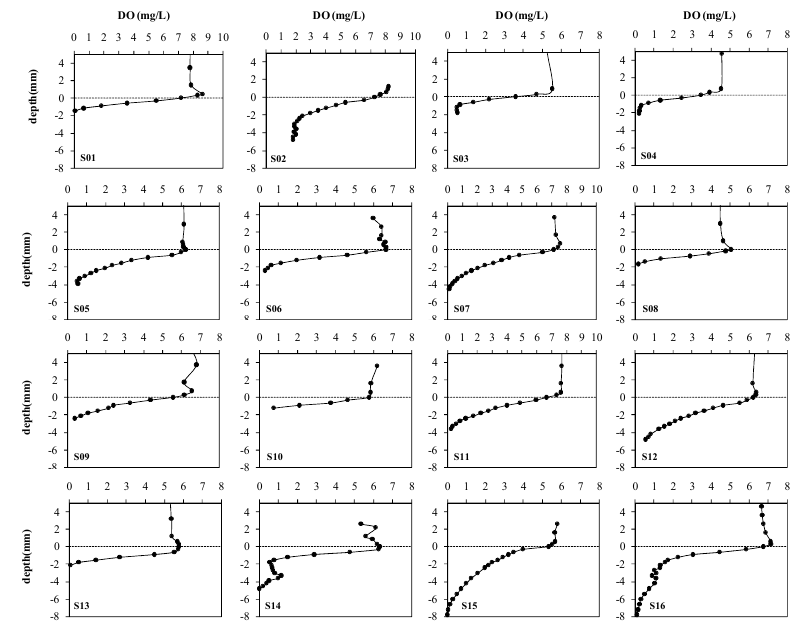
Figure 4. Sixteen microprofiles of dissolved oxygen in the sediment measured by microelectrodes during August 2003 at16sampling stations in the Ziya River Watershed.